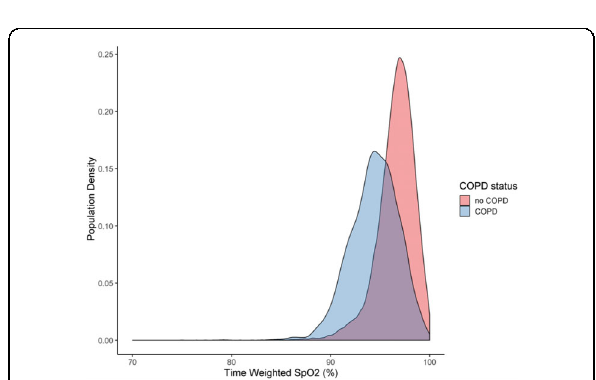
Fig. 2 (abstract 000290). Patients with COPD versus patients with no